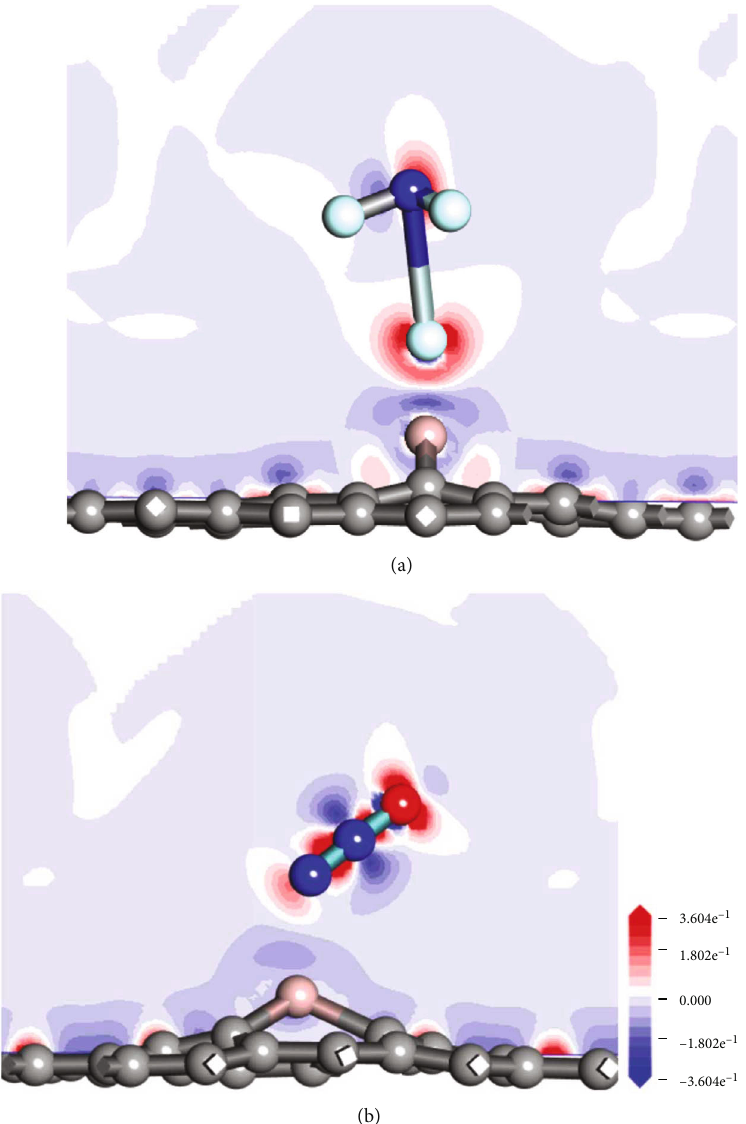
Figure 15: The charge di ff erence density of NF Ga-Graphene; (b) the charge di ff erence density of N